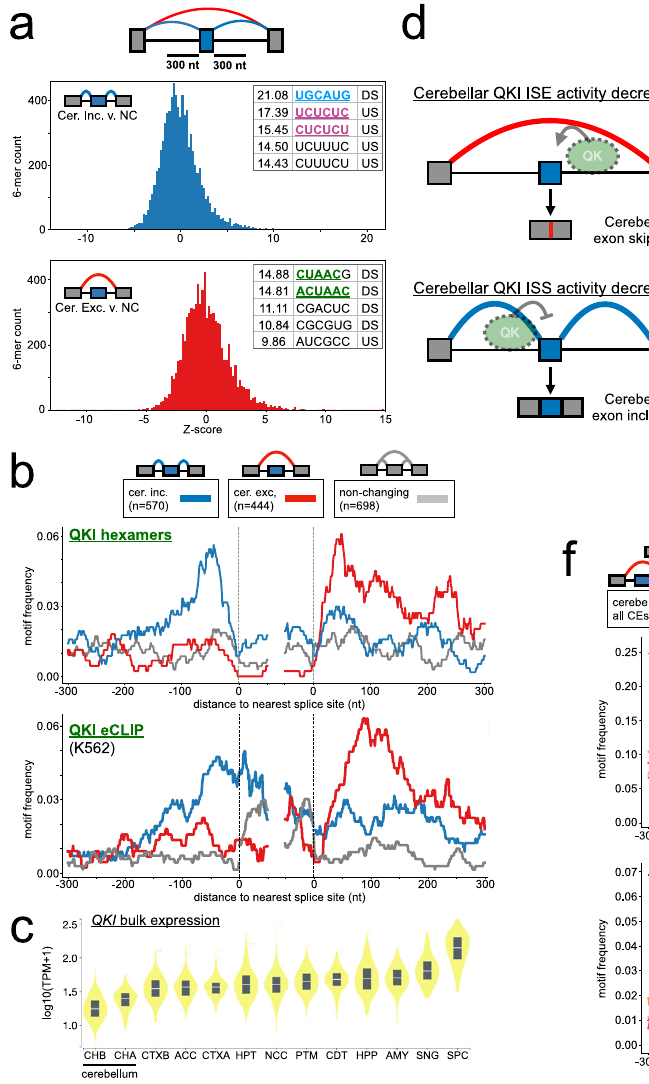
Fig. 6 | Regulatory analysis of simple and complex cerebellar cassette exon types. a Distribution of hexamer Z -scores within 300 nucleotides upstream or downstream of all CE event types (Fig. 5c) for cerebellar inclusion versus non- changing(top,blue)orcerebellarexclusionversusnon-changing(bottom,red)(see “ Methods ” ). Top motifs for RBPs of interest are highlighted (QKI (green), RBFOX (blue),SRRM4(yellow),SRSF11orPTB(purple)).Allmotifsand Z -scoresaregivenin Supplementary Data 1. b RNAmaps showing the frequency of QKI hexamers (ACUAAY, top) or binding of QKI (K562 eCLIP peaks, bottom) around cerebellar inclusion(blue),exclusion(red),ornon-changing(gray)CEs.Frequenciescalculated over windows of 20 nucleotides smoothed by a running mean of 5 nucleotides. c GTEx QKI brain tissue expression (log 10 1+TPM ð Þ ) generated using